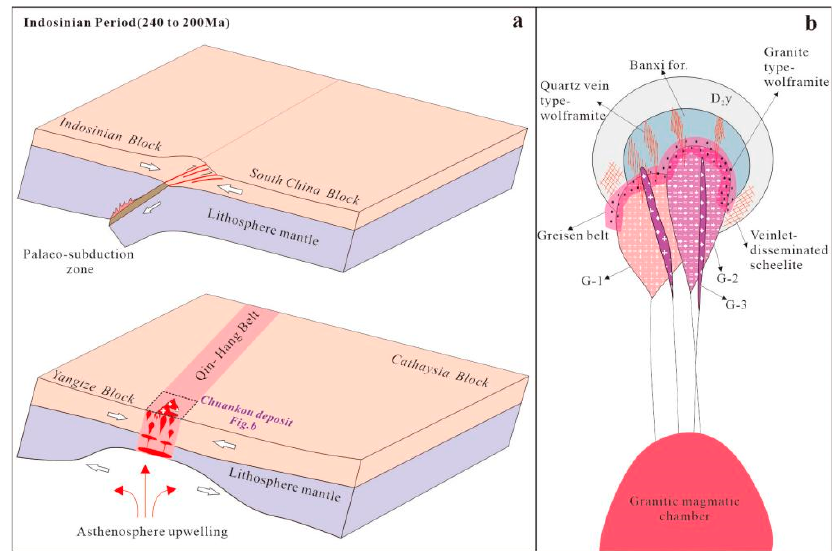
Figure 19. ( a ) Model explaining the geodynamic setting for the Indosinian W mineralization in SC and ( b ) Model explaining the formation of the granitoids and their relationship to tungsten